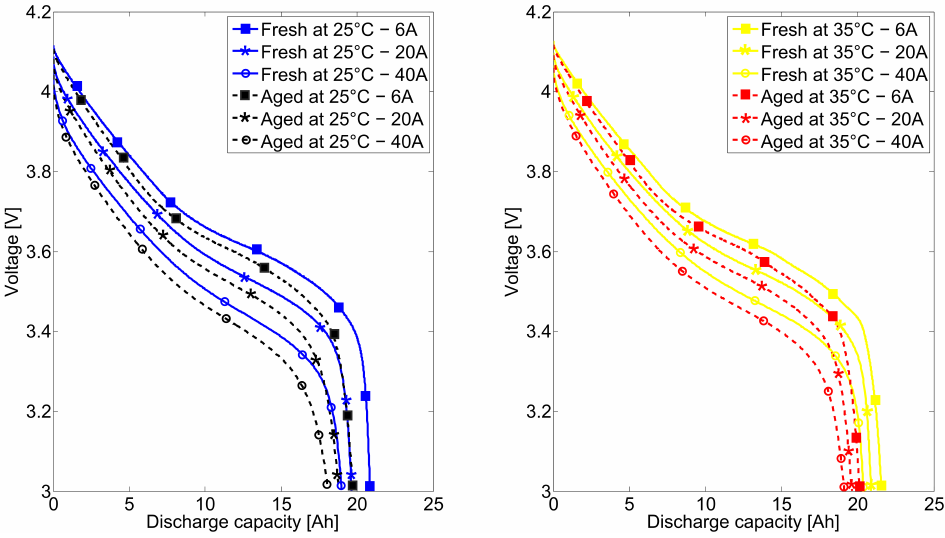
Figure 13. Discharge capacity at 25 ◦ C and 35 ◦ C of the fresh and aged cells at various current rates.